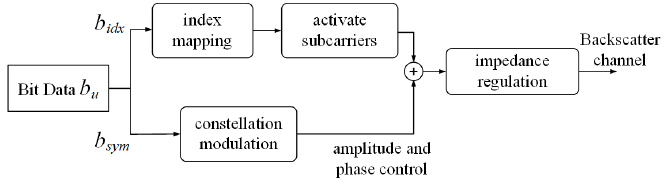
Figure 3. OFDM backsca tt er fl ow with index modulation.